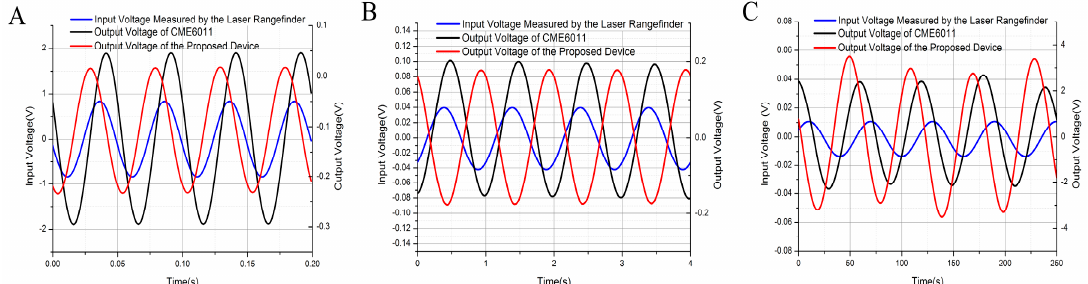
Figure 5. Input voltages measured by the laser rangefinder and the output voltages of CME 6011 and the proposed device @20 Hz ( A ) @0.18 mm/s, @1 Hz@0.17 mm/s ( B ), and @0.016 Hz@3.4 mm/s ( C ).